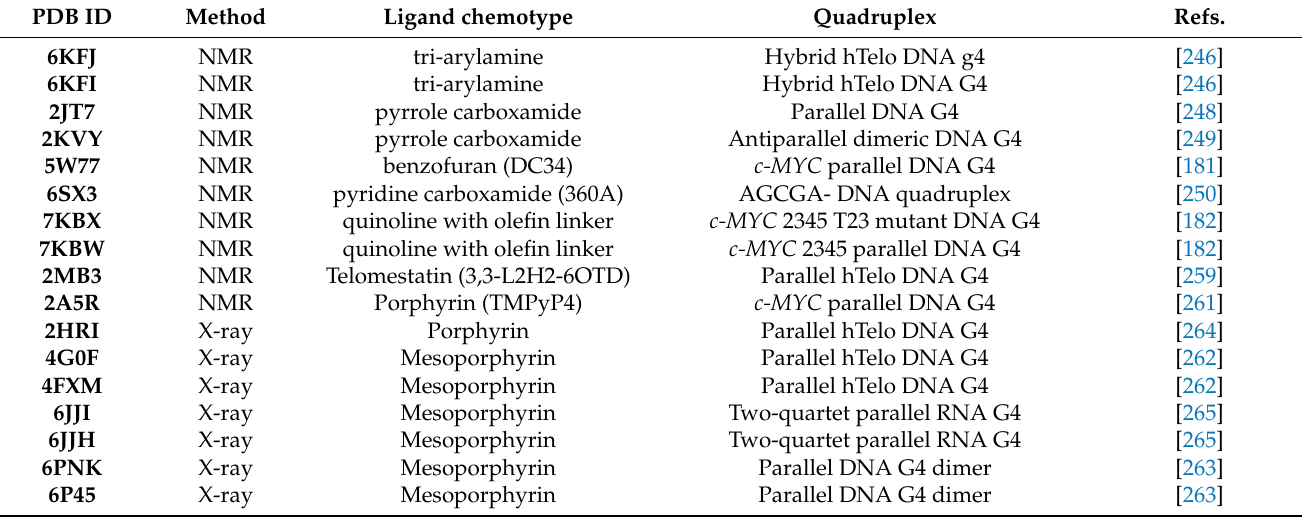
Table 5. Summary table with reference complex structures of G4s with modular aromatic ligands and macrocycles available at the RCSB Protein